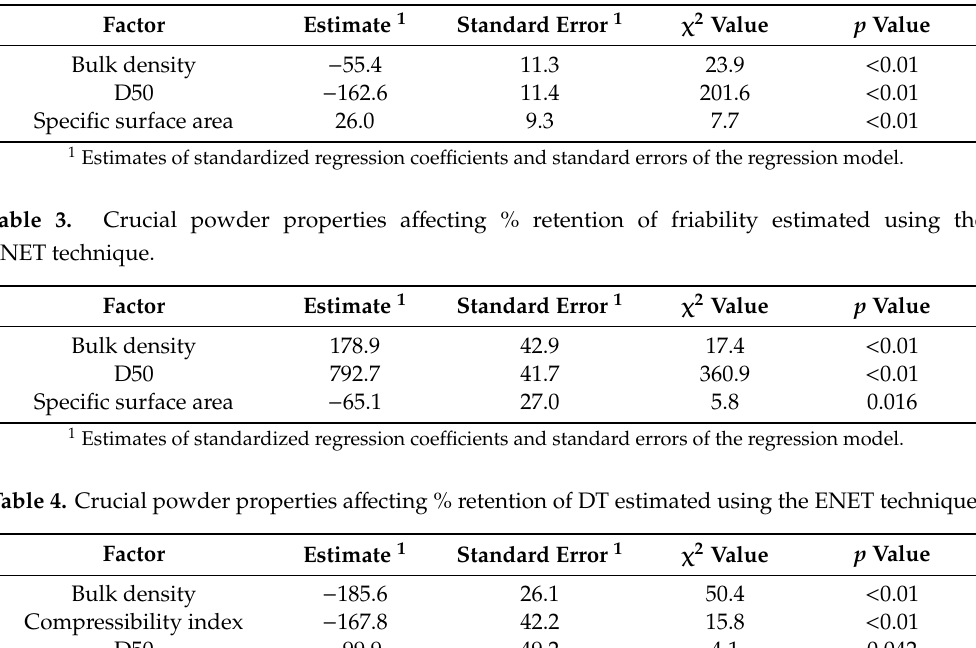
Figure S1: Microscopic images of direct compaction grades of mannitol. Particles of each mannitol grade were observed using a digital microscope (VHX-6000; Keyence, Tokyo, Japan). These images were acquired at 200 × or 500 × . Figure S2: Relationships between tablet properties. (A) % retention of TS vs. % retention of friability, (B) % retention of TS vs. % retention of DT, (C) % retention of friability vs. % retention of